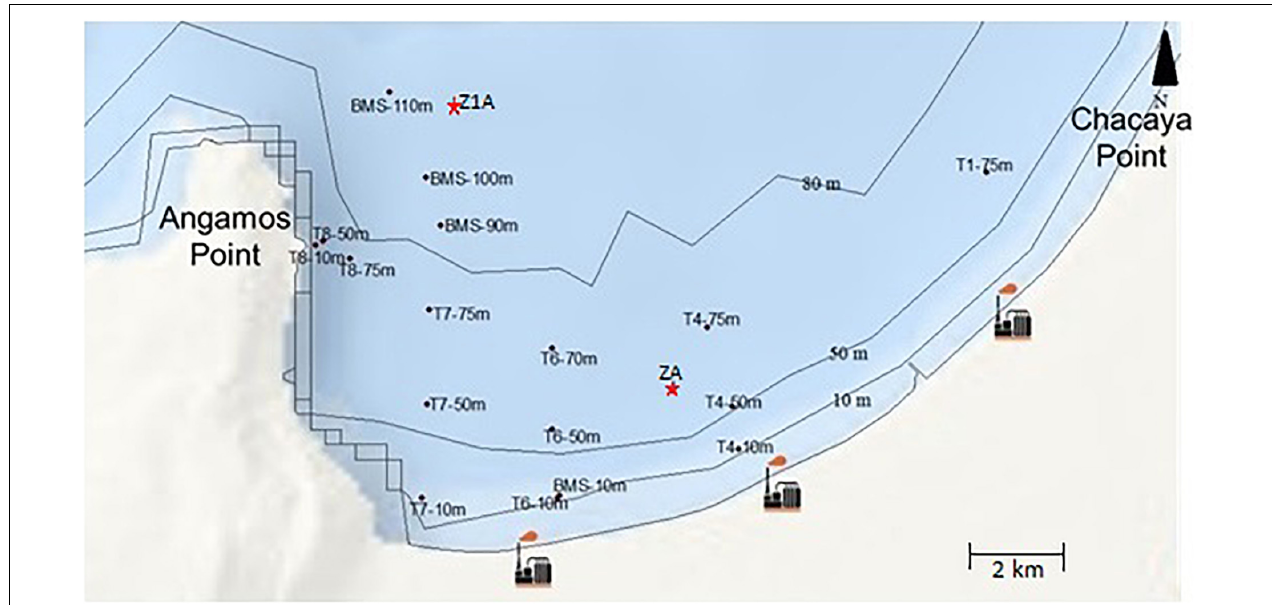
FIGURE 1 | Location of sampling stations for the analysis of spatial distribution (T and BMS) and vertical distribution (ZA and Z1A cores) and industrial activity in Mejillones Bay, northern Chile.